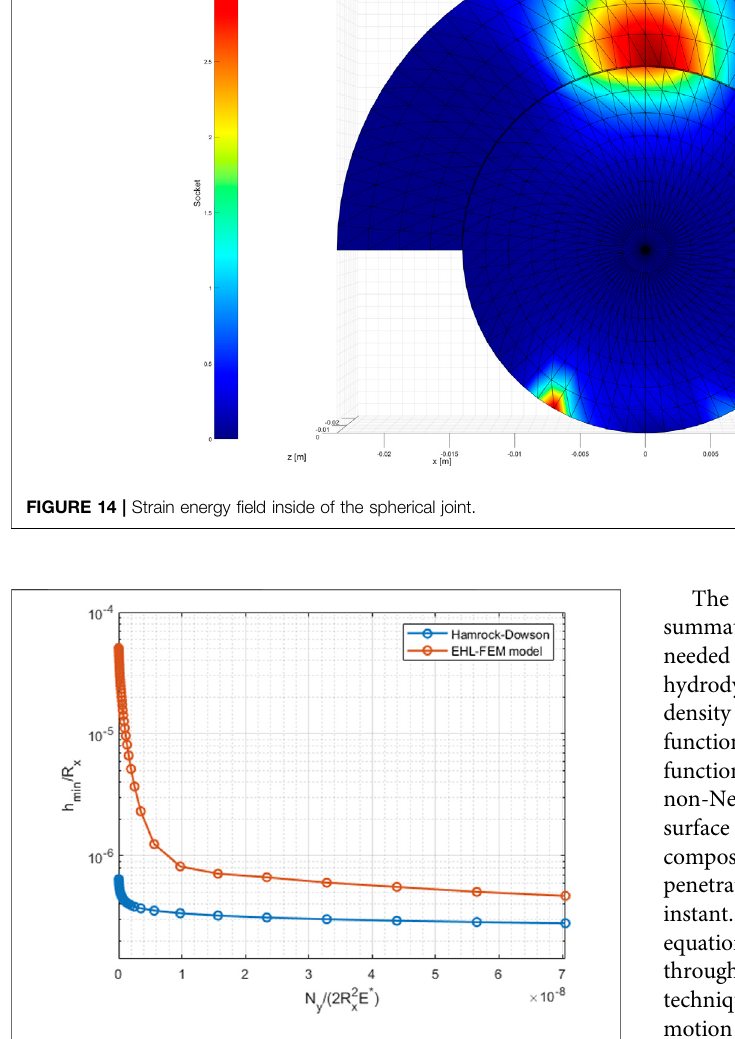
FIGURE 15 | Minimum fi lm thickness comparison with the Hamrock – Dowson